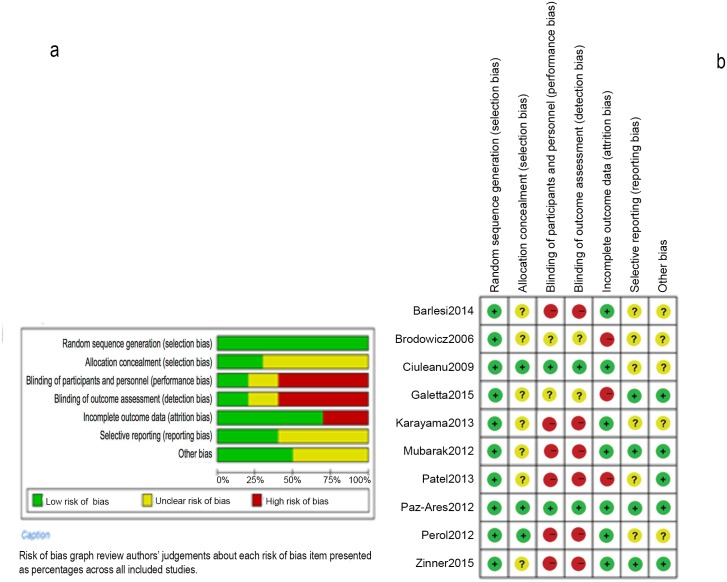
Risk of bias graph (a) and risk of bias summary (b).